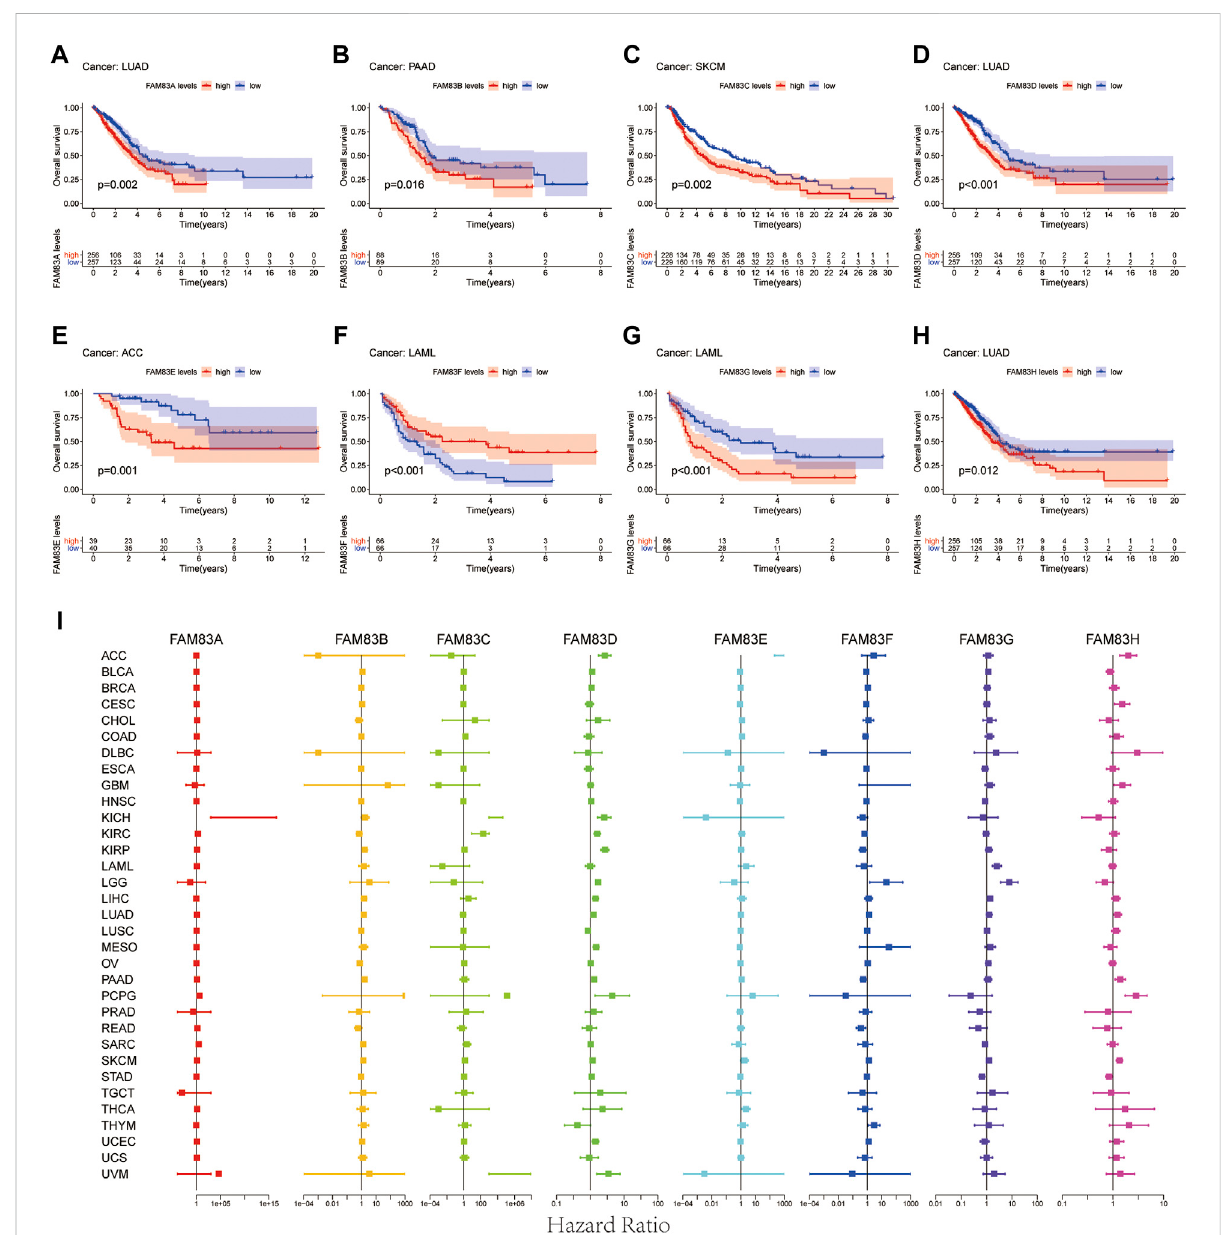
FIGURE 3 SurvivalanalysisofFAM83familygenesacrosscancers. (A – H) KMcurvesfortheprognosticvalueoftheFAM83familygene.Onlypartialsurvival charts with p < 0.05are displayed. (I) UnivariateCox proportionalhazard regressionanalysis between the FAM83 family and overall survival.A hazard ratio > 1 is considered a high-risk factor for cancer, with an adverse prognostic outcome. In contrast, a hazard ratio of < 1 is deemed a low-risk factor for